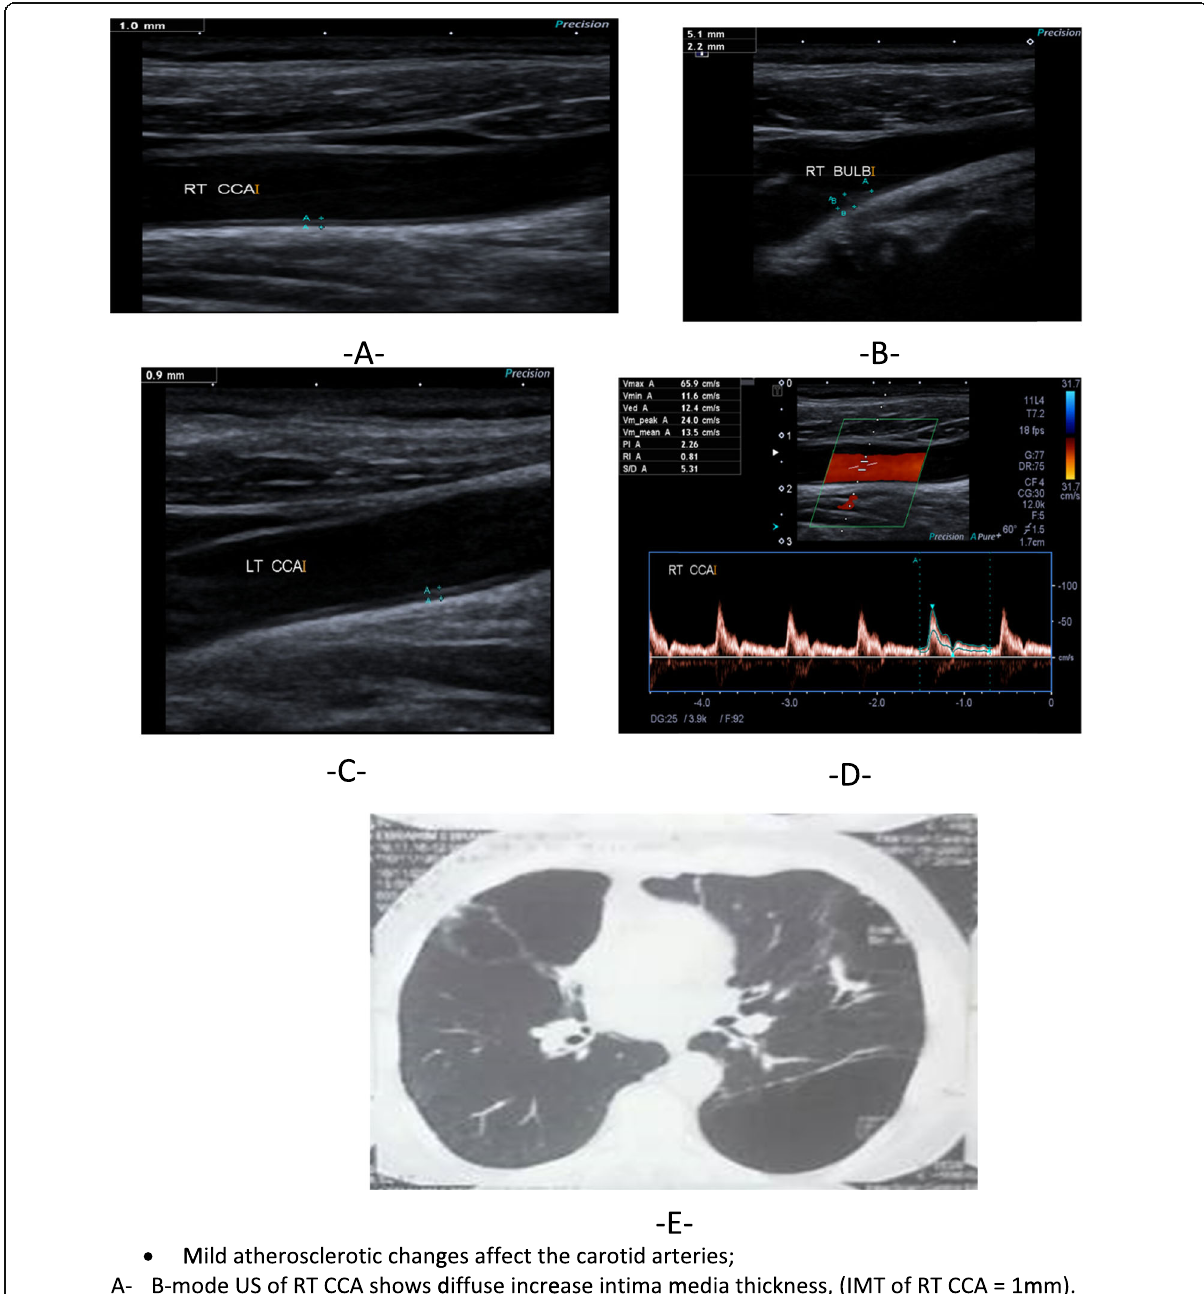
Fig. 4 A case of severe emphysematous changes and mild carotid arteries atherosclerotic